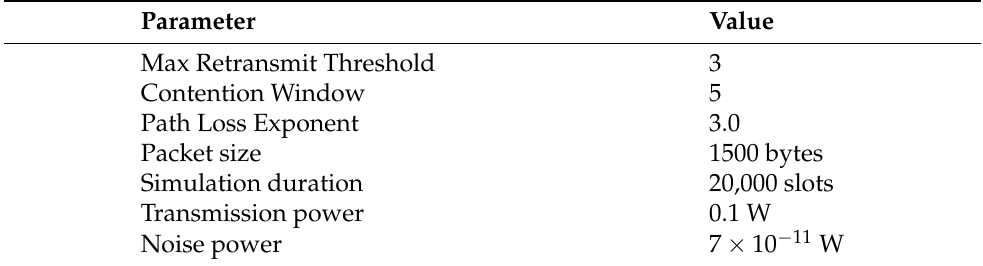
Table 6. Values for the network parameters that are used in the numerical and simulation